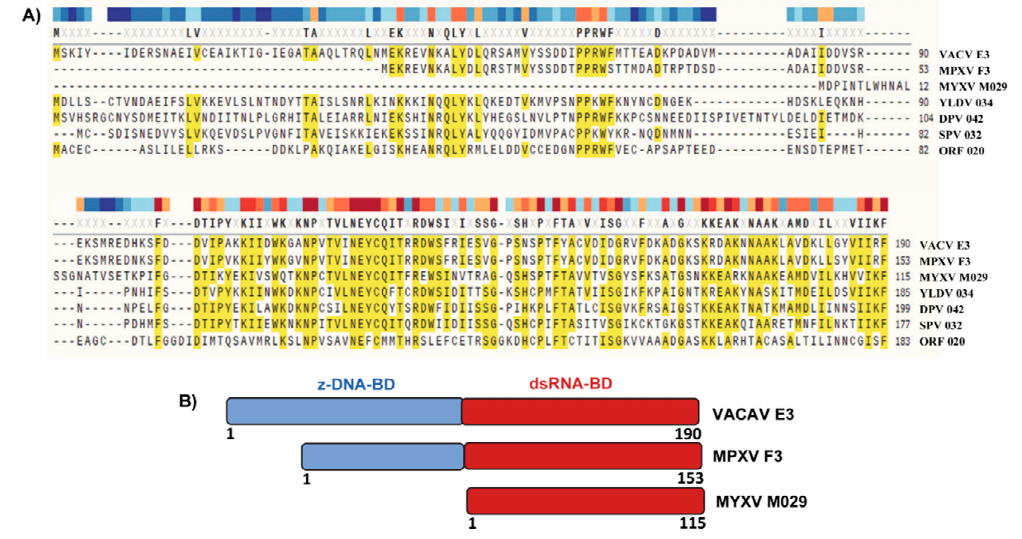
Figure 1. Protein sequence alignment of E3-like proteins. ( A ) Protein sequence alignments of representative E3-like proteins encoded by di ff erent poxviruses were generated using the COBALT program (www.ncbi.nlm.nih.gov). ( B ) Schematic diagram of the E3-like protein domains encoded by vaccinia virus (VACV), monkeypox virus (MPXV) and myxoma virus (MYXV).